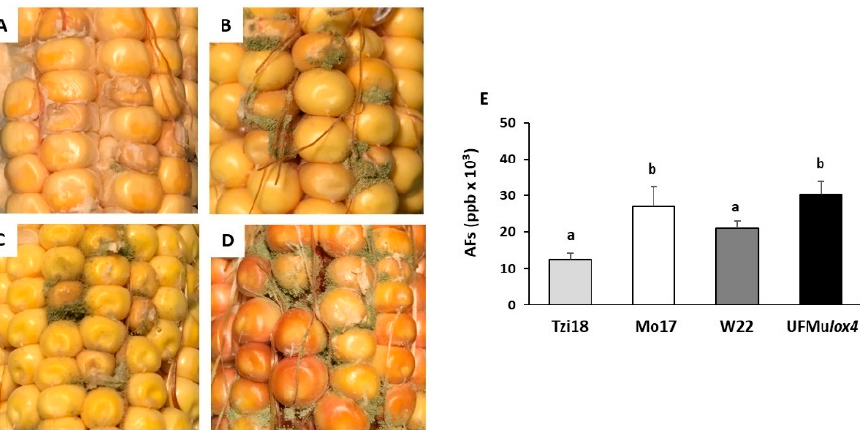
Figure 3. Phenotypic evaluation of Aspergillus ear rot disease among the lines ( A ) Tzi18, ( B ) Mo17, ( C ) W22, ( D ) UFMu lox4 mutant, and ( E ) content of total aflatoxins (AFs, B 1 + B 2 + G 1 + G 2 ) in artificially inoculated kernels at 7 dpi with A. flavus . Vertical bars indicate the standard error. The different letters over the histograms indicate significant differences in the aflatoxin content among the tested lines, as resulting from the Tukey multiple comparison test ( p ≤ 0.05).